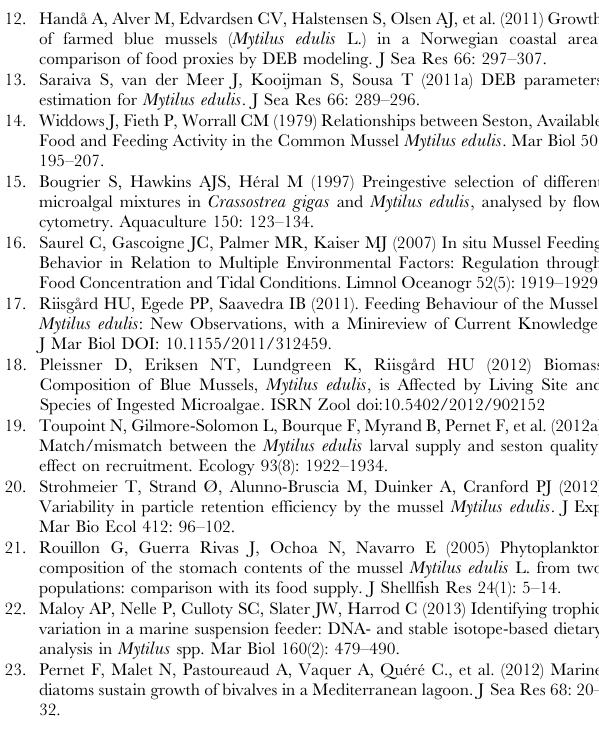
Figure S1 Comparisons of observed and modeled DFM as a function of cubed length. Figure S2 Example of an eigenvector contribution to the model coefficients for the smallest eigenvalue, using a model optimizing the scaling coefficient c i and simultaneous contributions of a i and b i . (TIFF) Figure S3 Evolution of the parameter identifiability with the number of species taken into account. The condition number of the Hessian matrix of the model cost function